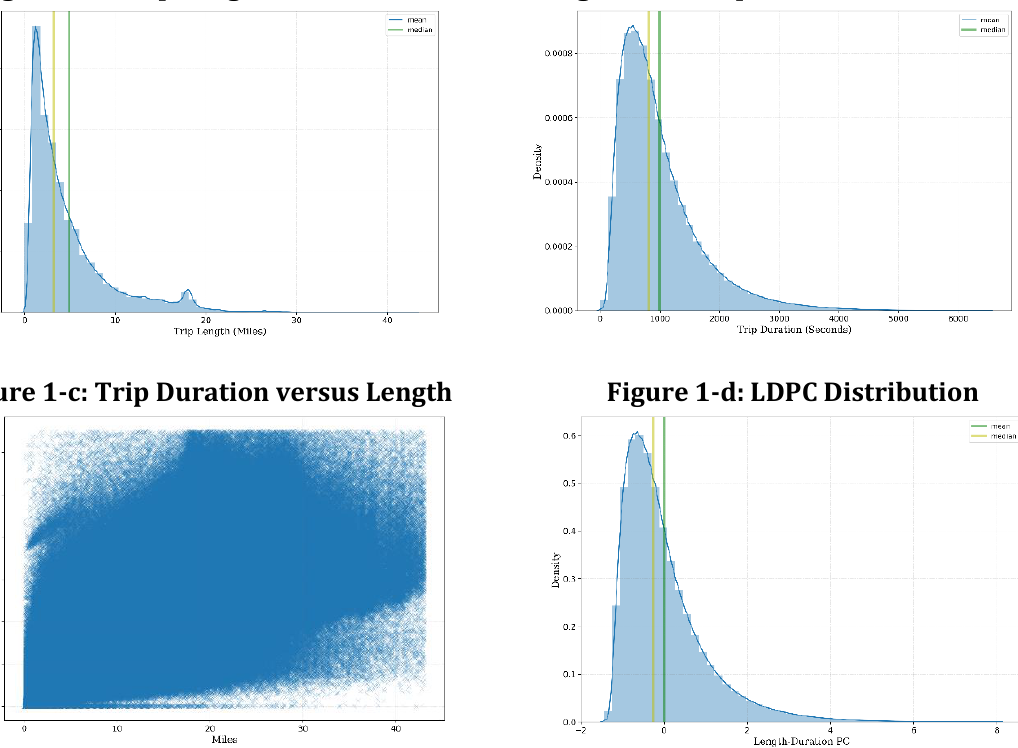
Figure 1-b: Trip Duration Distribution